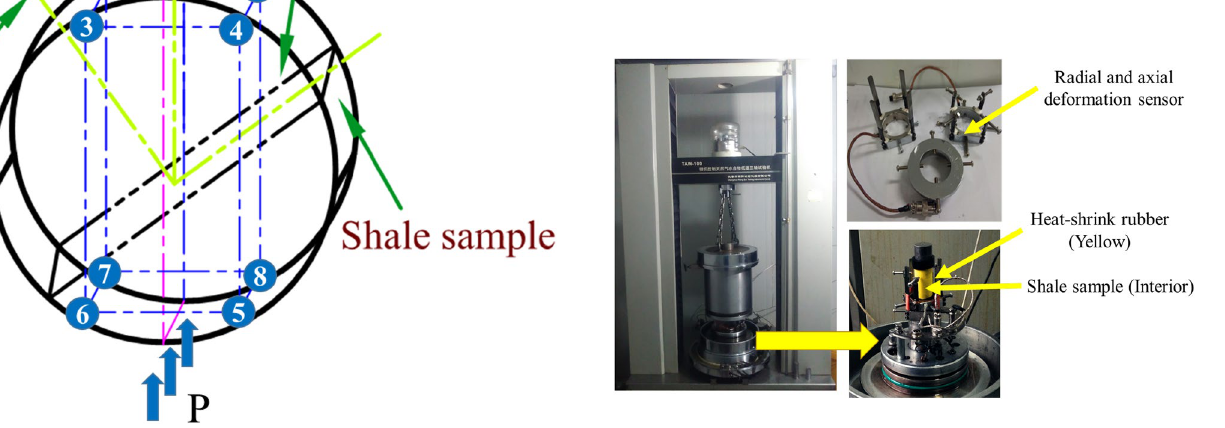
Fig. 1 Loading of shale disc-shaped sample